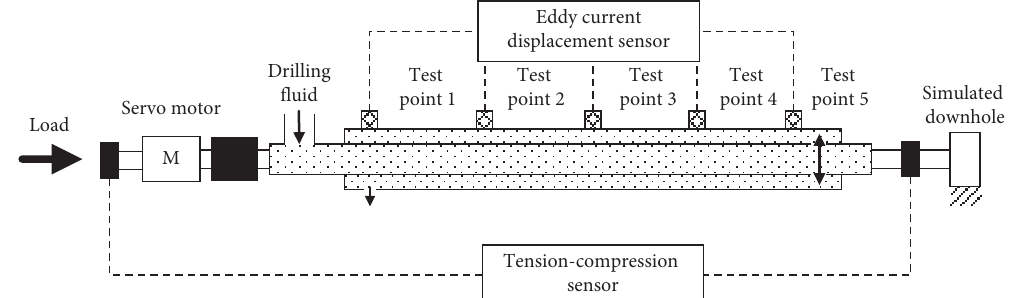
Figure 9: Schematic diagram of the experiment apparatus.